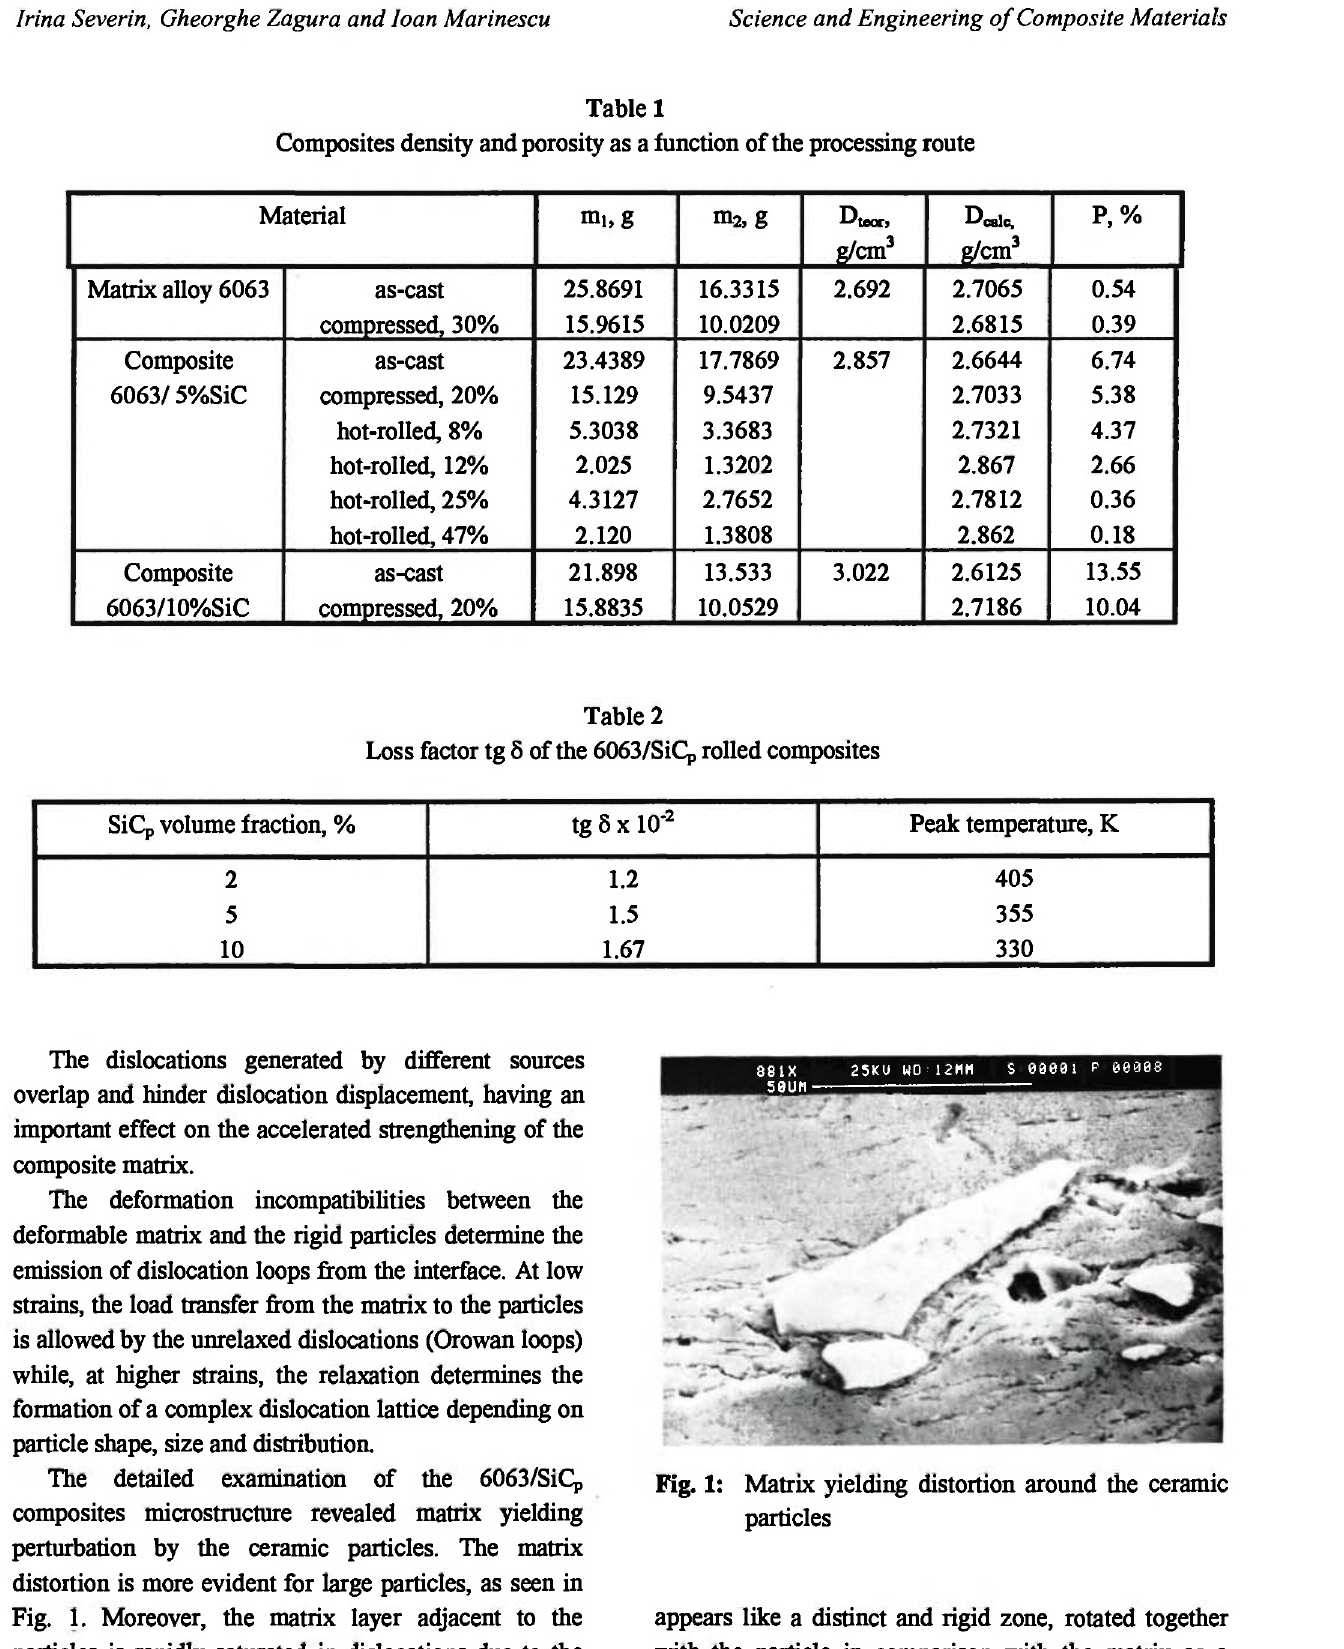
appears like a distinct and rigid zone, rotated together with the particle in comparison with the matrix as a result of residual stresses relaxation (Fig. 2a, 2b). When